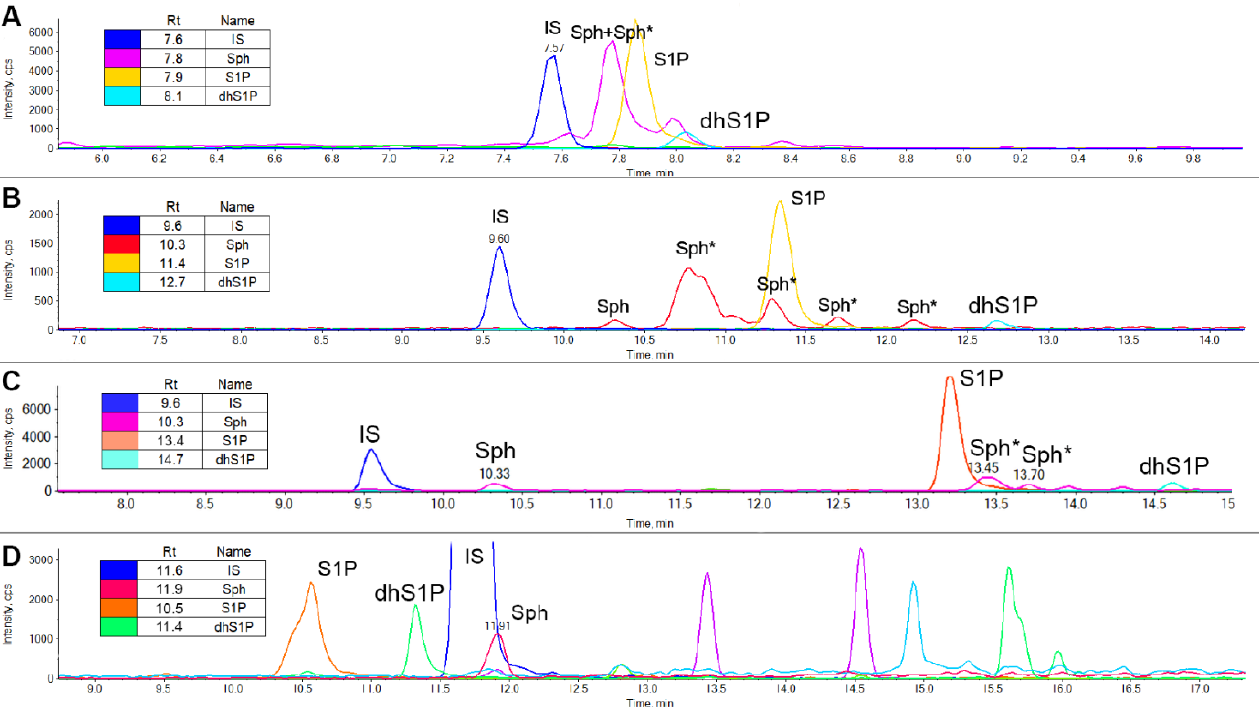
Figure 3. Chromatograms of plasma-free sphingoid bases analyzed by ( A ) Acquity BEH C18 with a short chromatography elution program, ( B ) Acquity BEH C18 with a long chromatography elution program, ( C ) Cortecs C18 with a long chromatography elution program and ( D ) Acquity BEH C18 with a long chromatography elution program after chemical derivatization with phenylisothiocyanate. In each panel * indicates the interferences on sphingosine transition. dhSph is not always appreciable since its concentration is markedly lower than other sphingosine bases. See Materials and Methods for the detailed LC-MS/MS conditions.